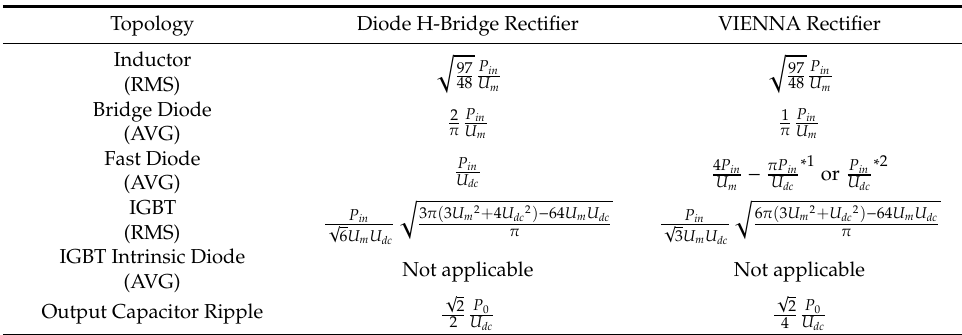
*1 represent the current stresses of D 2 and D 4 in VIENNA topology. *2 represent the current stresses of D 5 and D 6 in VIENNA topology.